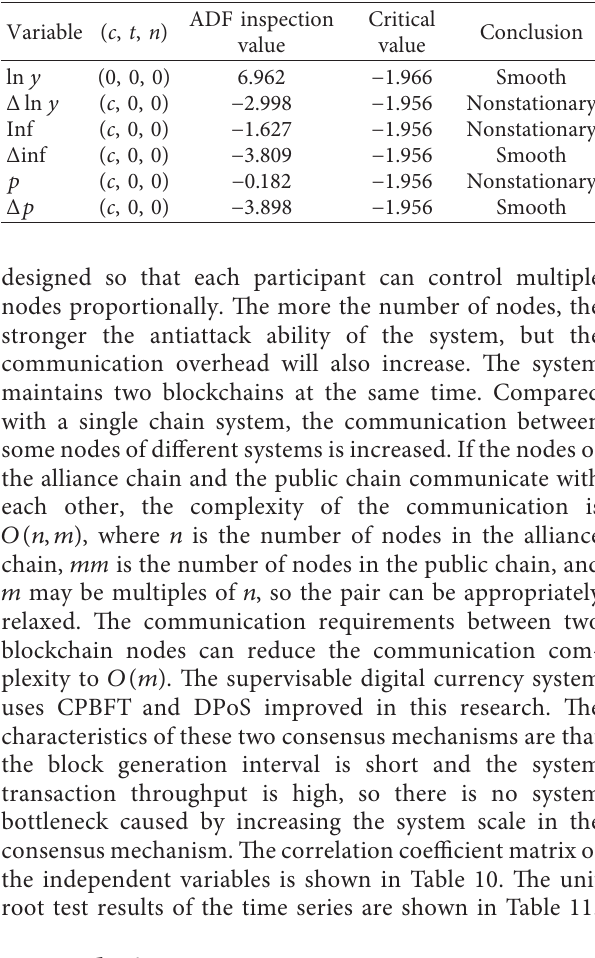
Table 11: Time series unit root test